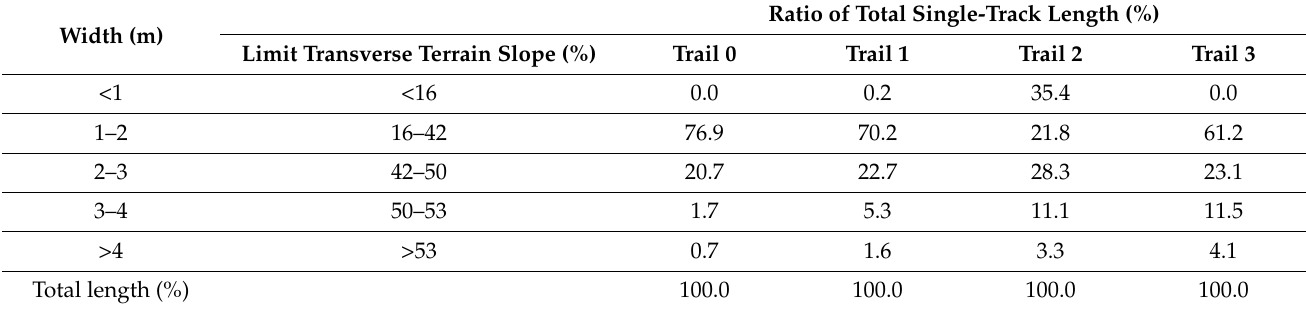
Table 4. Trail width parameters.